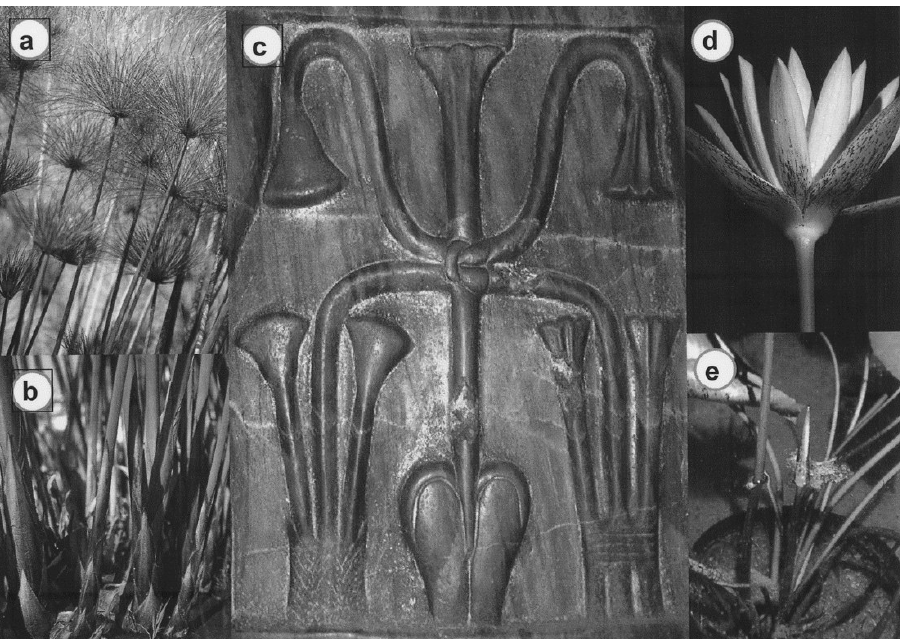
Figure 2. The “Union” Symbol (sema-taui) of ancient Egypt. ( a ) Fertile stalks of the papyrus plant present a cluster of chaffy bracts and a spray of slender shoots. Details of these complex structures are often simplified as a campanulate motif in the visual arts (Figure 2c). ( b ) Papyrus stems are supported at their base by long, chaffy bracts. ( c ) Early renderings of the sema-taui symbol portray a central lotus stalk that is supported by knotted lotus and papyrus stems. Note that the central stalk arises from a testicular base and supports a three-membered palmette (lotus flower) at its apex. Throne of Chephren, Giza, 26th c. BCE (Cairo Museum). ( d ) The profile view of a polypetalous Egyptian water lily exhibits three prominent green sepals and a palmate array of blue-pigmented petals. ( e ) Lotus stalks lack the distinctive basal bracts of a papyrus shoot. Note that a new bud has arisen before a flower stalk has finished its three days of anthesis.